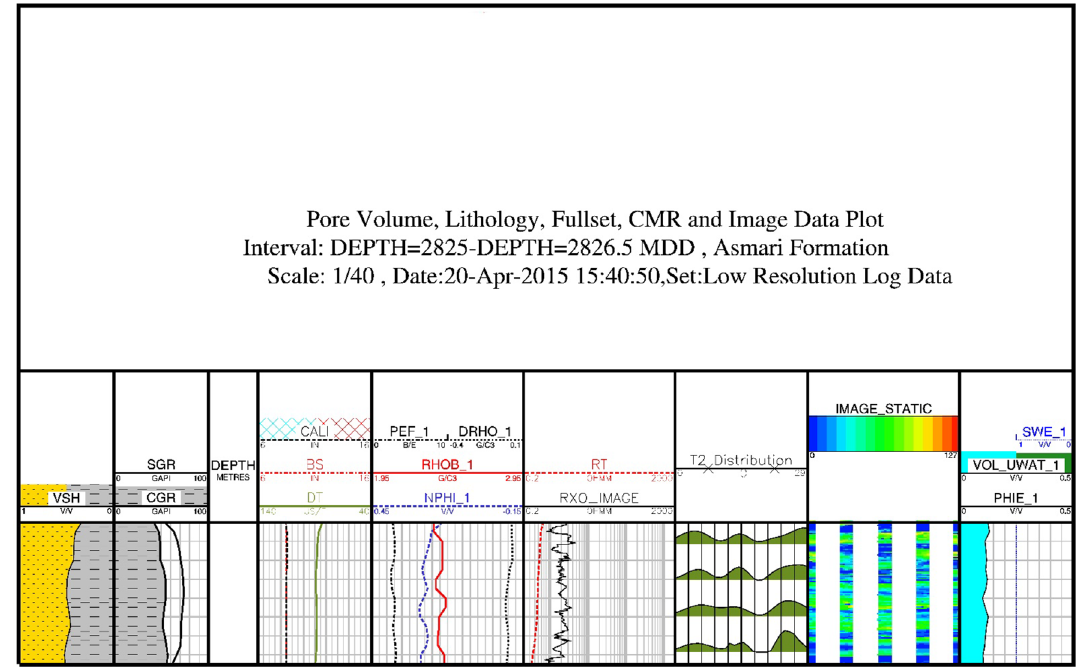
Fig. 3 Available logs in the LSS